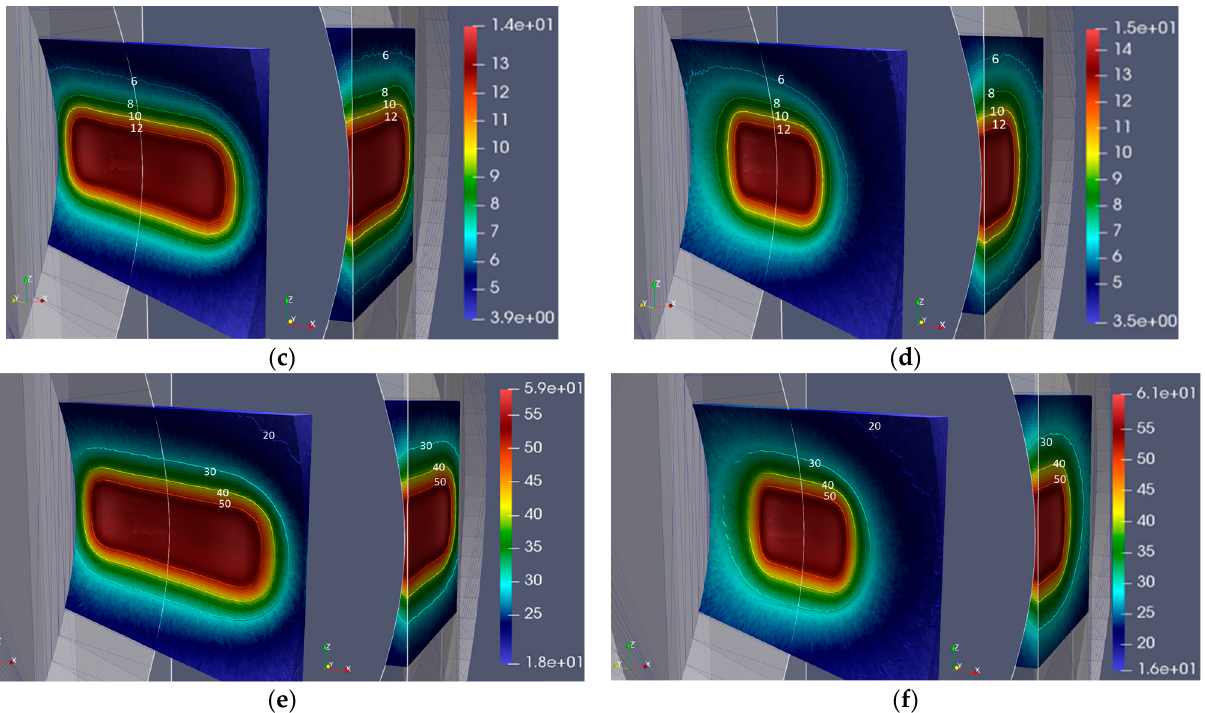
Figure 7. DPA (dpa/fpy), the ratio of helium production to DPA (He-appm/dpa), and the ratio of hydrogen production to DPA (H-appm/dpa) for the footprints “20 × 5” and “10 × 5”. ( a ) DPA, “20 × 5”; ( b ) DPA, “10 × 5”; ( c ) He–DPA ratio, “20 × 5”; ( d ) He–DPA ratio, “10 × 5”; ( e ) H–DPA ratio, “20 × 5”; ( f ) H–DPA ratio, “10 × 5”.